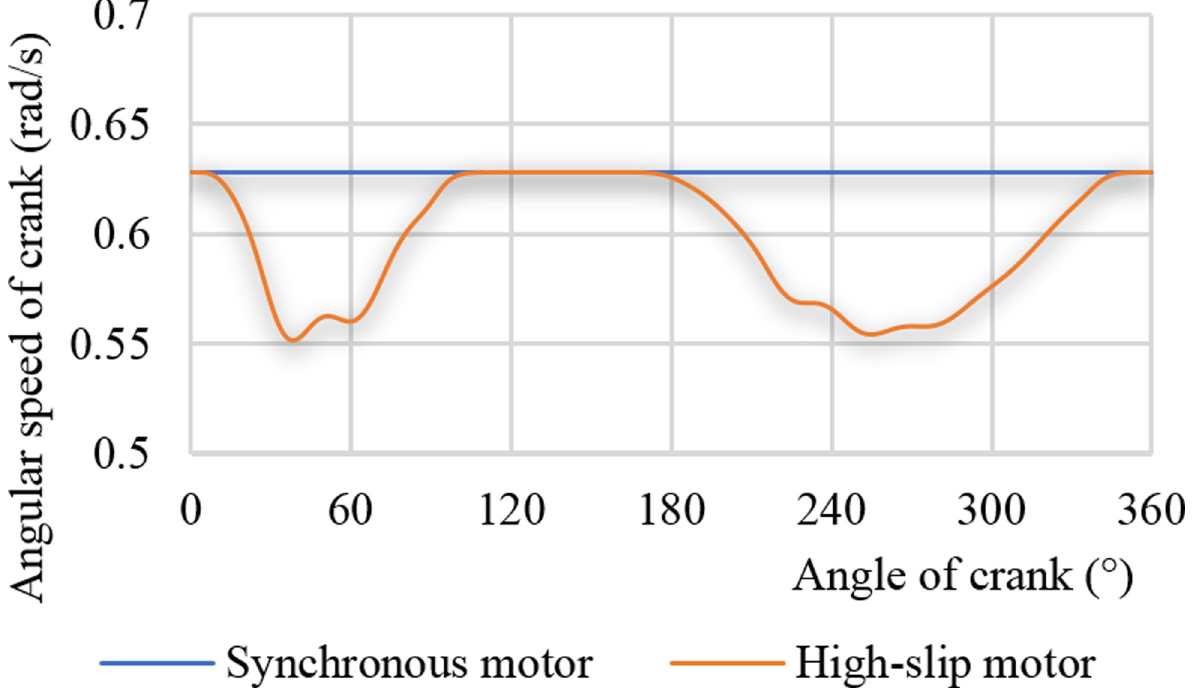
Fig 4. Angular velocity curves of